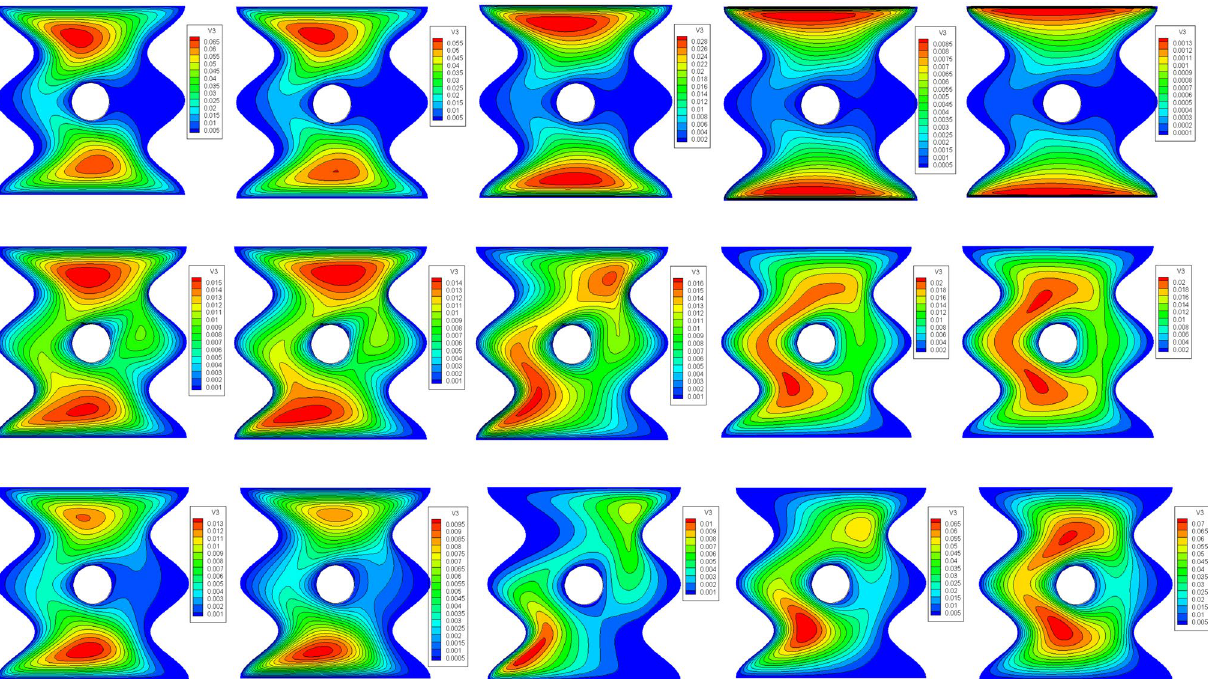
TiO –Cu/water hybrid nanofluid at the moderate values; Ha = 10 , 2 Q = 1 , Ri = 1 , Gr = 1 , H * = 10 , R = 0 . 5 , ε = 0 . 5 , γ = 0 . 5 , Φ = π/ 3 , λ = , α = , c d ϕ Cu = ϕ TiO 2 = ϕ / 2 , ϕ = 0 .